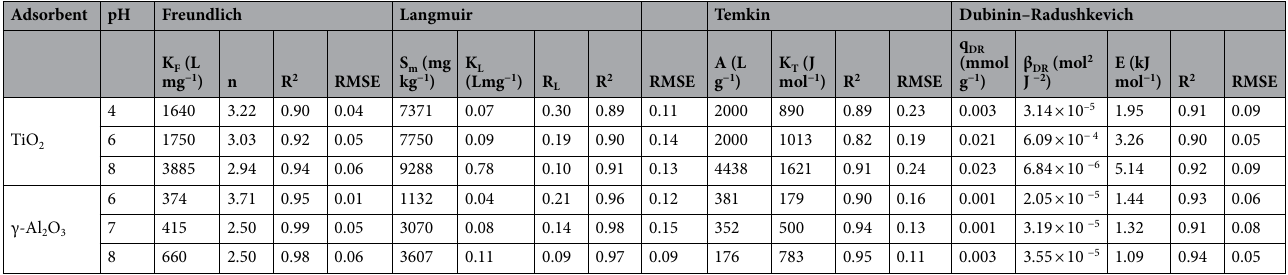
Table 3. Calculated isotherm equation parameters for adsorption of Cu(II) by TiO 2 and γ-Al 2 O 3 nanoparticles. K F Freundlich equation constant; n empirical constant of the Freundlich equation; S m maximum adsorption capacity; K L Langmuir equation constant; A empirical constant; K T constant value of the Temkin equation; q